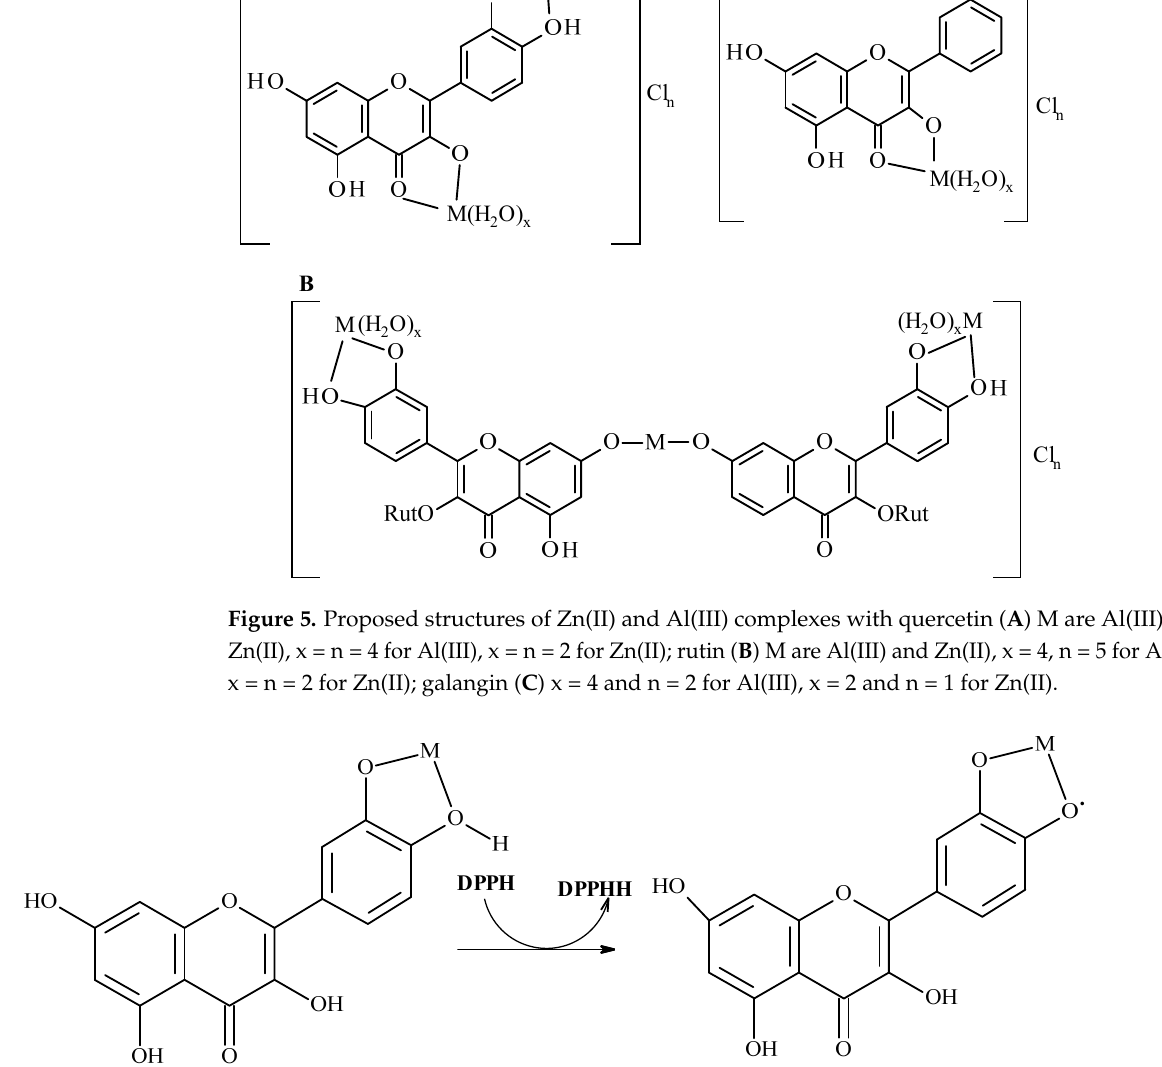
Scheme 1. Scheme of oxidation pathway for metal-quercetin complex through DPPH radical and with formation of semiquinone radical intermediate [241].